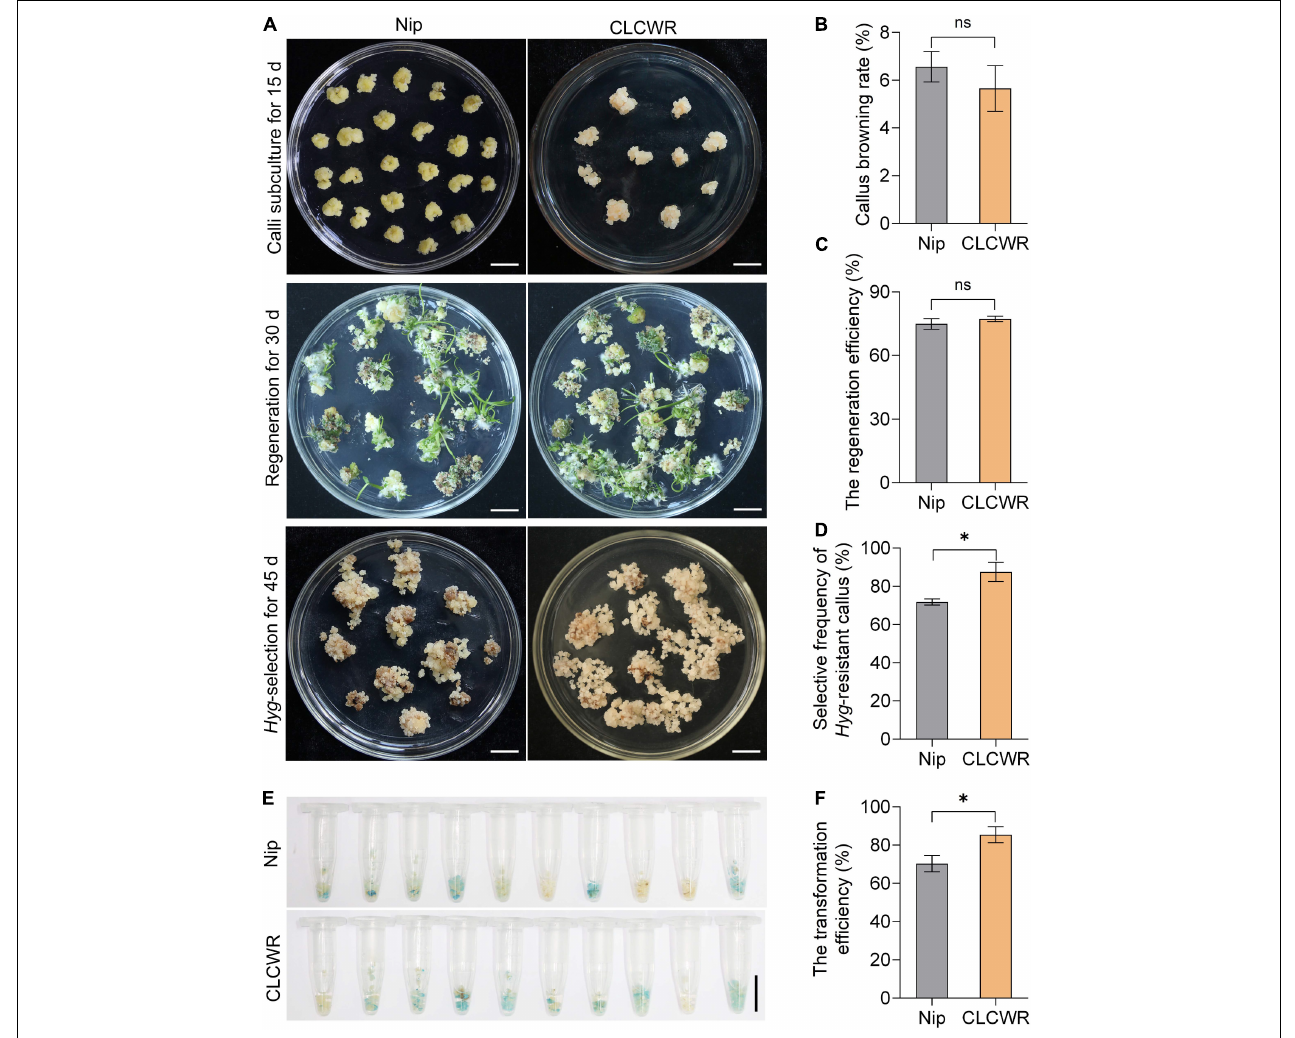
FIGURE 6 | Comparison of Agrobacterium -mediated transformation procedure between Nipponbare and CLCWR. (A) Callus subculture, regeneration and Hyg -resistant selection of Nip and CLCWR. For callus subculture, the calli induced for 10 days were transferred to callus induction medium containing 2, 4-D for 15 days. For regeneration, the fresh calli were cultured on the regeneration medium for 30 days. For Hyg -resistant selection, the Agrobacterium -infected calli were cultured on a selection medium for three rounds of 15 days each. Bars = 1 cm. (B–D) Comparison of the callus browning rate (B) , regeneration efficiency (C) , and selective frequency of Hyg -resistant callus (D) between Nip and CLCWR. (E) GUS staining of calli transformed with vector pCAMBIA1301-Pro OrNCED 5 -GUS. (F) Comparison of the transformation efficiency between Nip and CLCWR. Significant differences were found between Nip and CLCWR (* P < 0.01 by Student’s t -test). Data are means of three replicates of one experiment. The experiment was repeated three times with similar results. Error bars represent ± SD. *, significant; ns, not